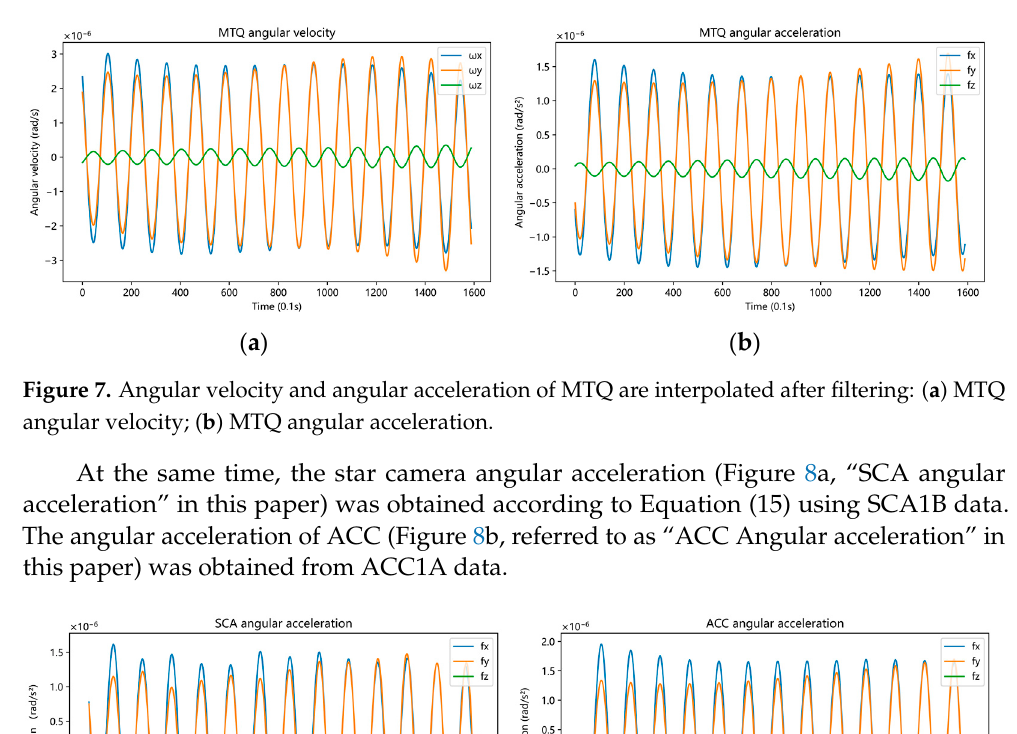
Figure 6. Angular velocity and angular acceleration signals applied by MTQ during the first CM-Cal maneuver: ( a ) angular velocity; ( b ) angular acceleration.